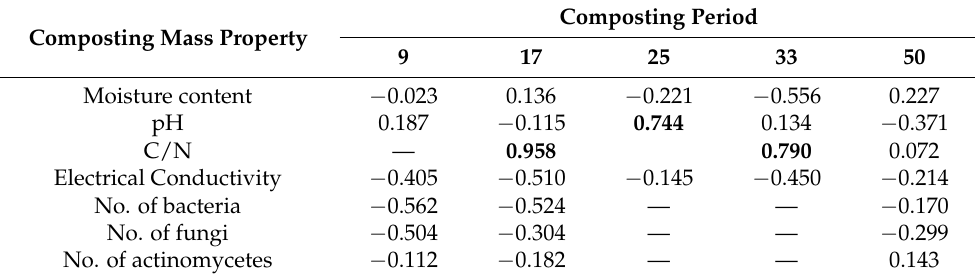
Table 5. Correlation coefficients between composting mass parameters in some days and temperature uniformity coefficients in the same